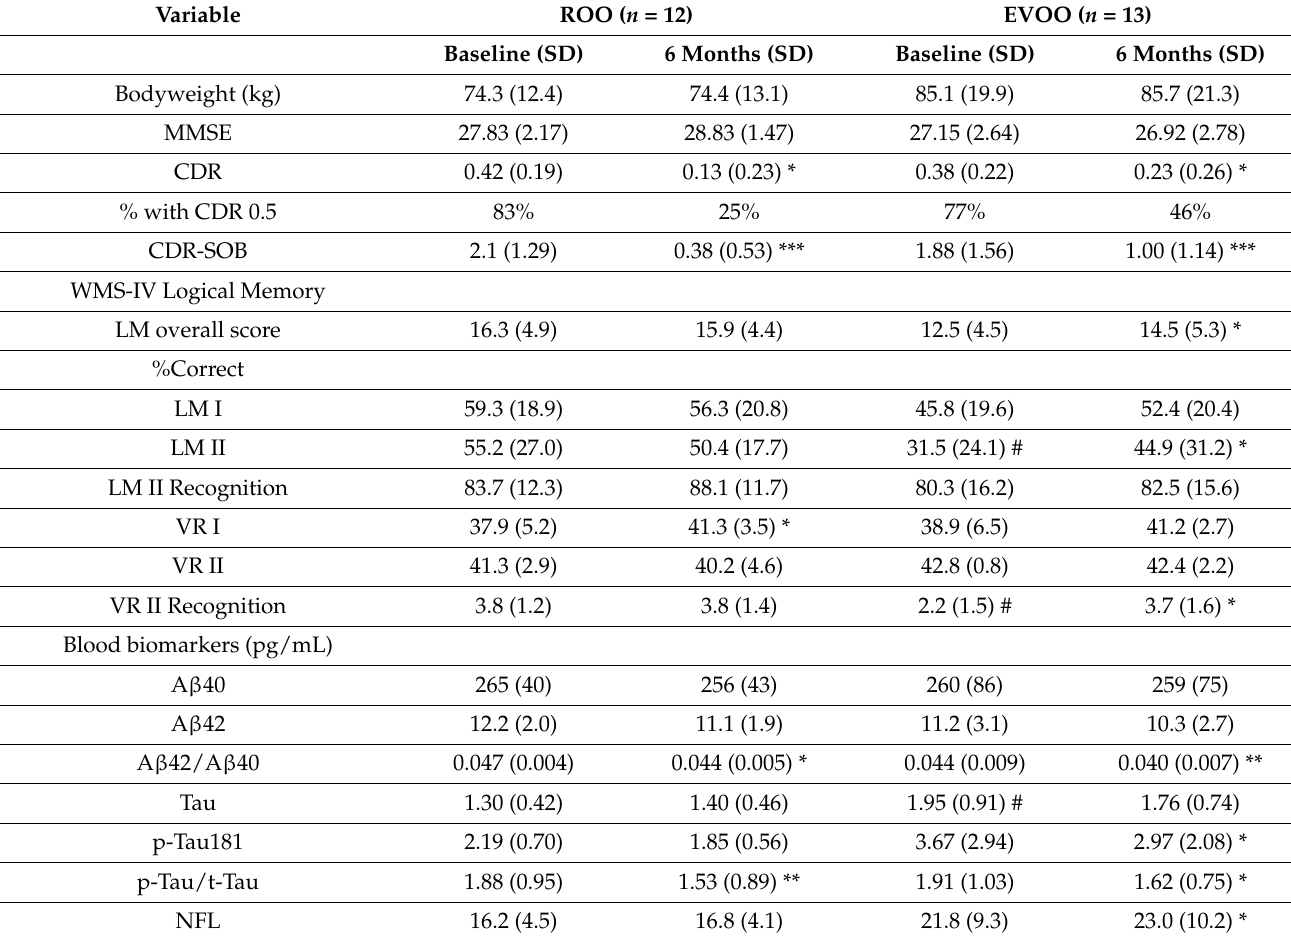
Table 3. Changes in cognitive outcomes and blood biomarkers.